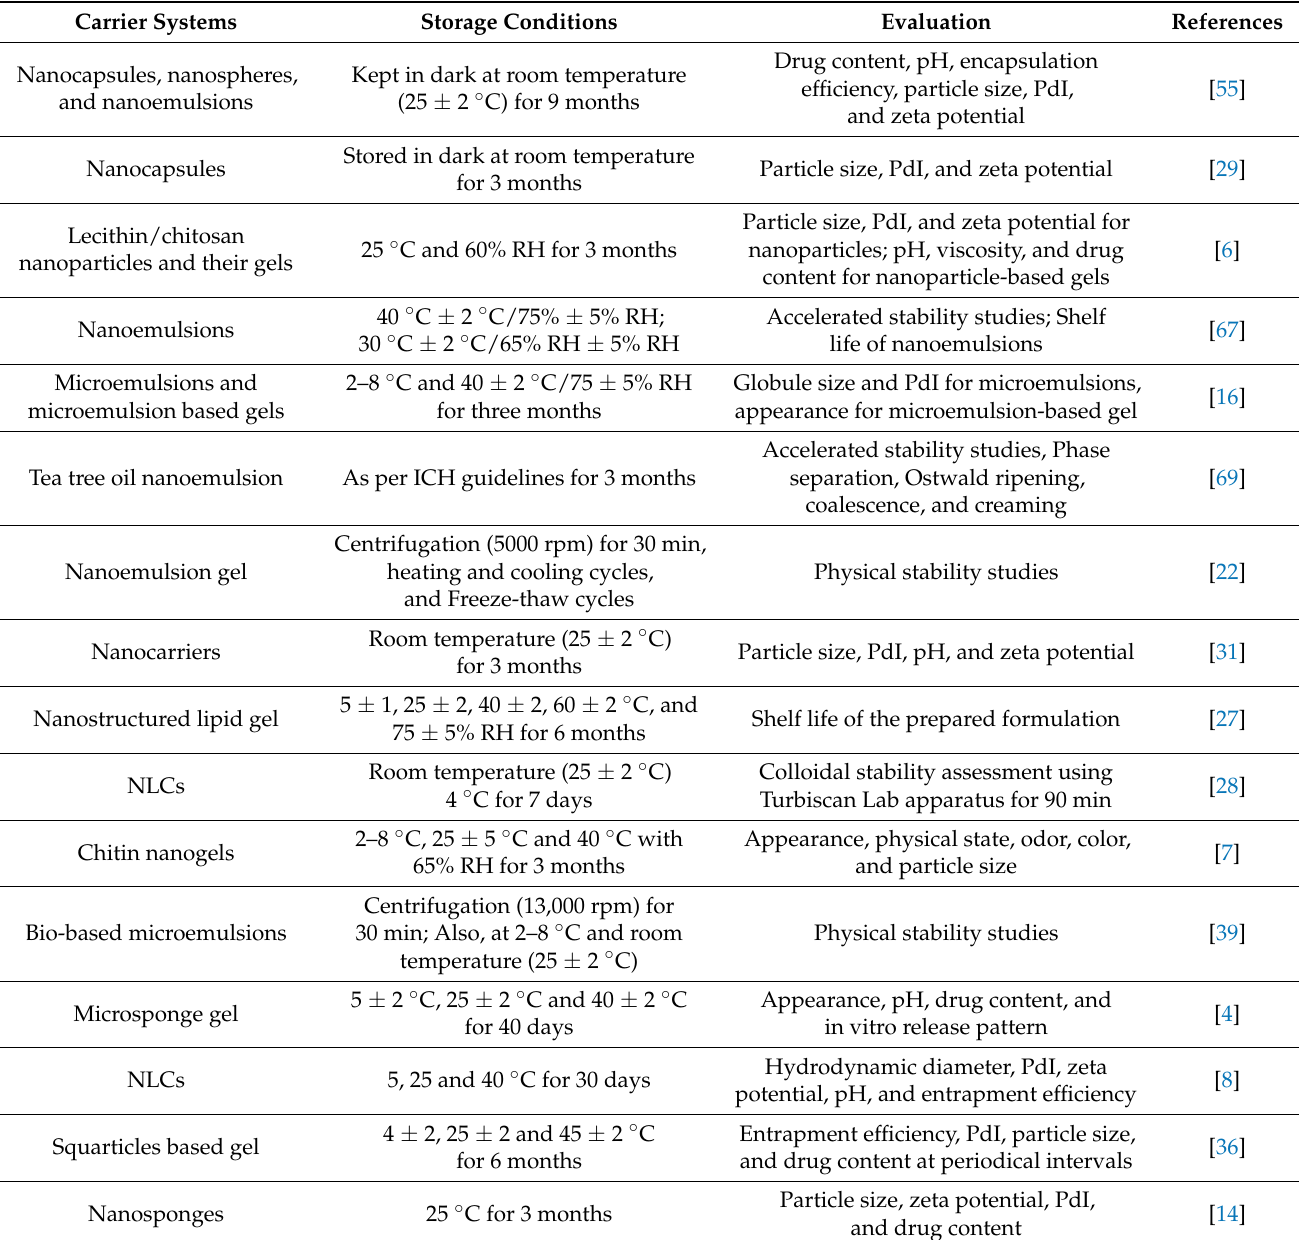
Table 4. Stability studies of the CP novel